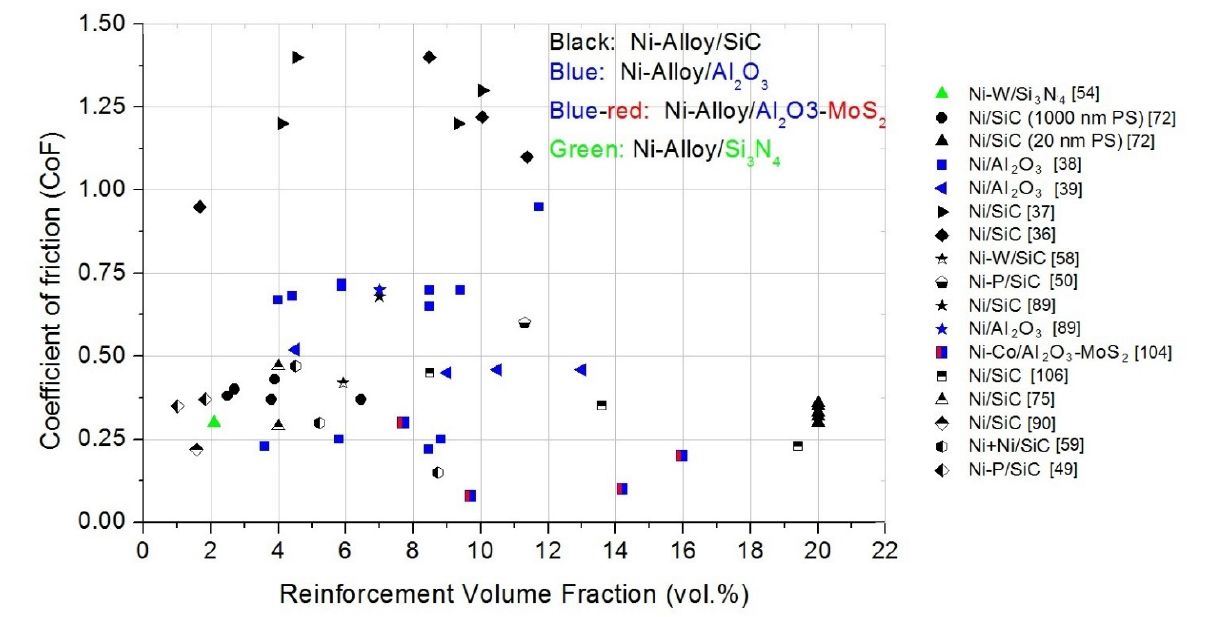
Figure 5. The effect of the reinforcement volume fraction on the CoF in Ni-alloy MMCs. The CoF graph includes only dry friction measurements at room temperature for MMCs without annealing.